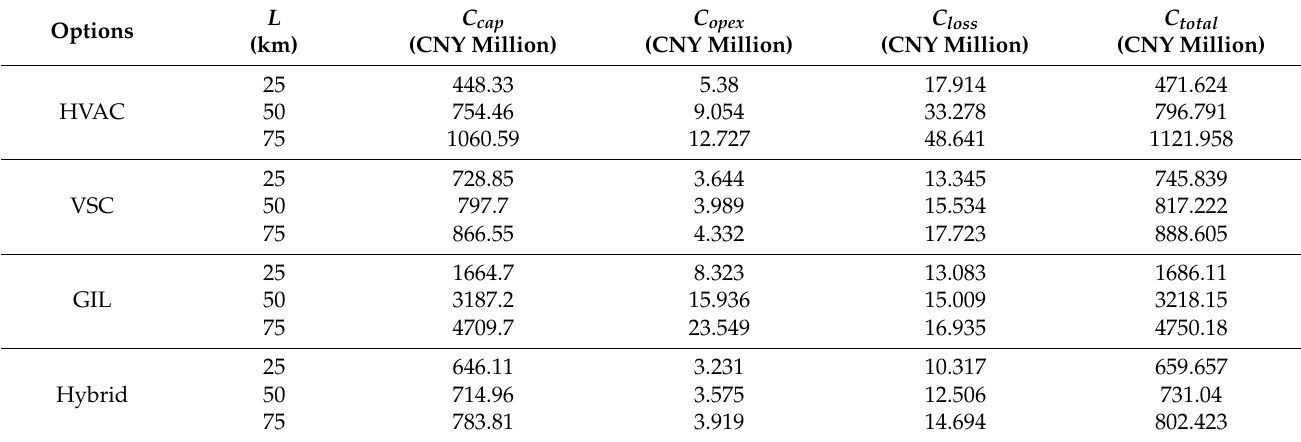
Table 4. Economic costs comparisons of different P and different L